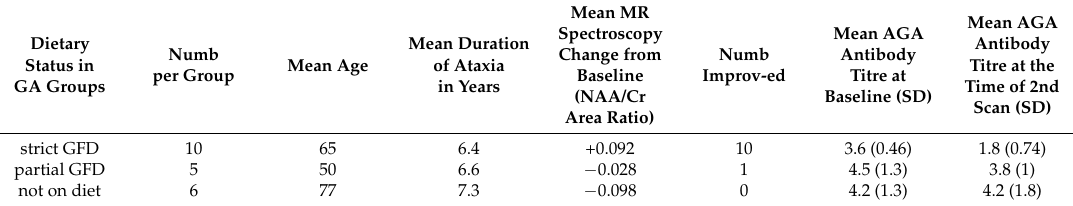
Table 1. Summary of clinical characteristics and the change in magnetic resonance spectroscopy and antigliadin antibody titre at baseline and at the time of the second scan in the 3 groups. The differences in numbers improved and in the changes in MR spectroscopy between the strict GFD and the not on GFD groups were significant p < 0.0001. There were no significant clinical differences between the strict GFD and the partial or not on diet groups. The patients on partial GFD were significantly younger than the other 2 groups. GA = gluten ataxia; NAA/Cr = N Acetyl Aspartate to Creatine ratio; GFD = Gluten Free Diet; AGA = Antigliadin antibodies; SD standard deviation.